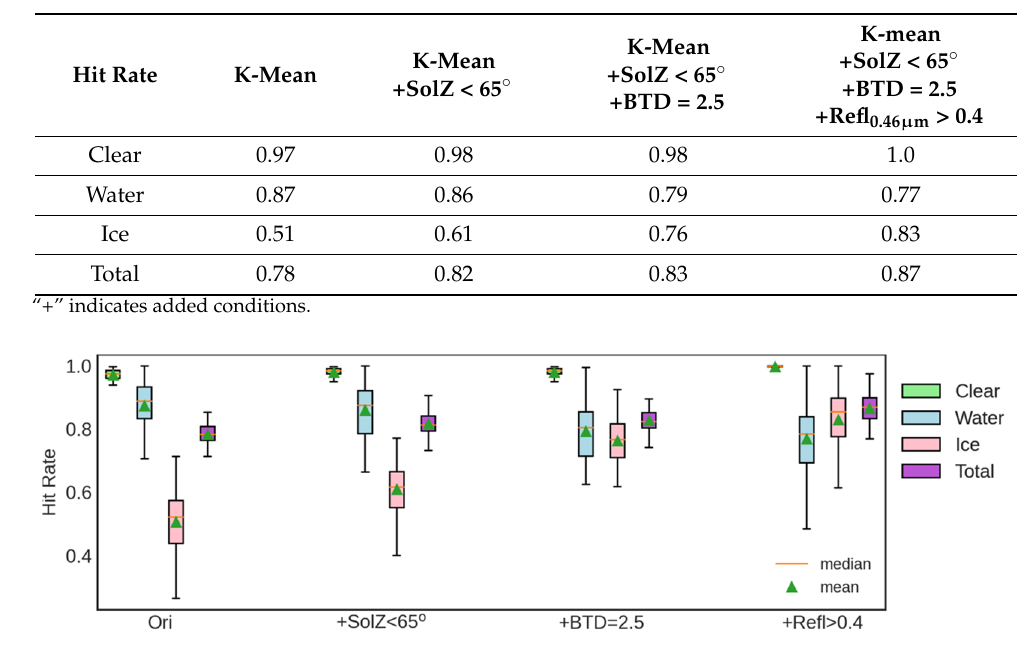
Table 3. The hit rate under different conditions.